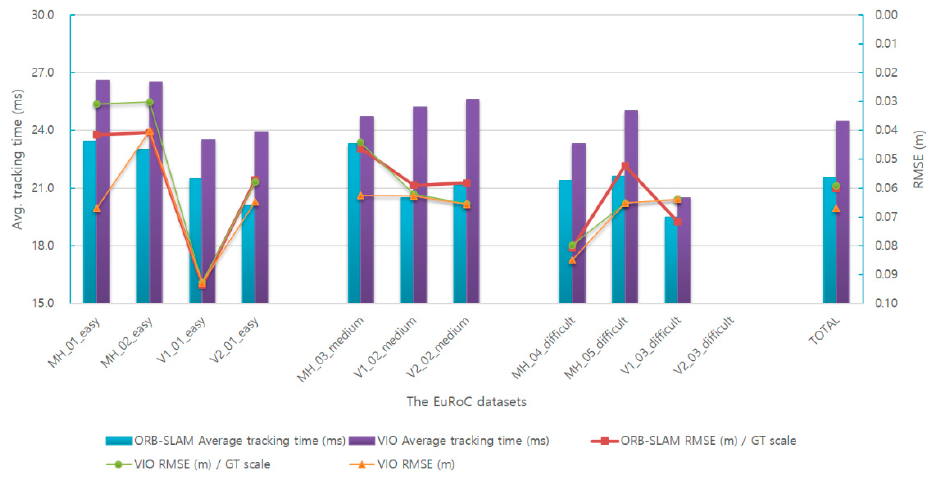
Figure 13. Evaluation of VIO-based SLAM and comparison with the monocular ORB-SLAM.